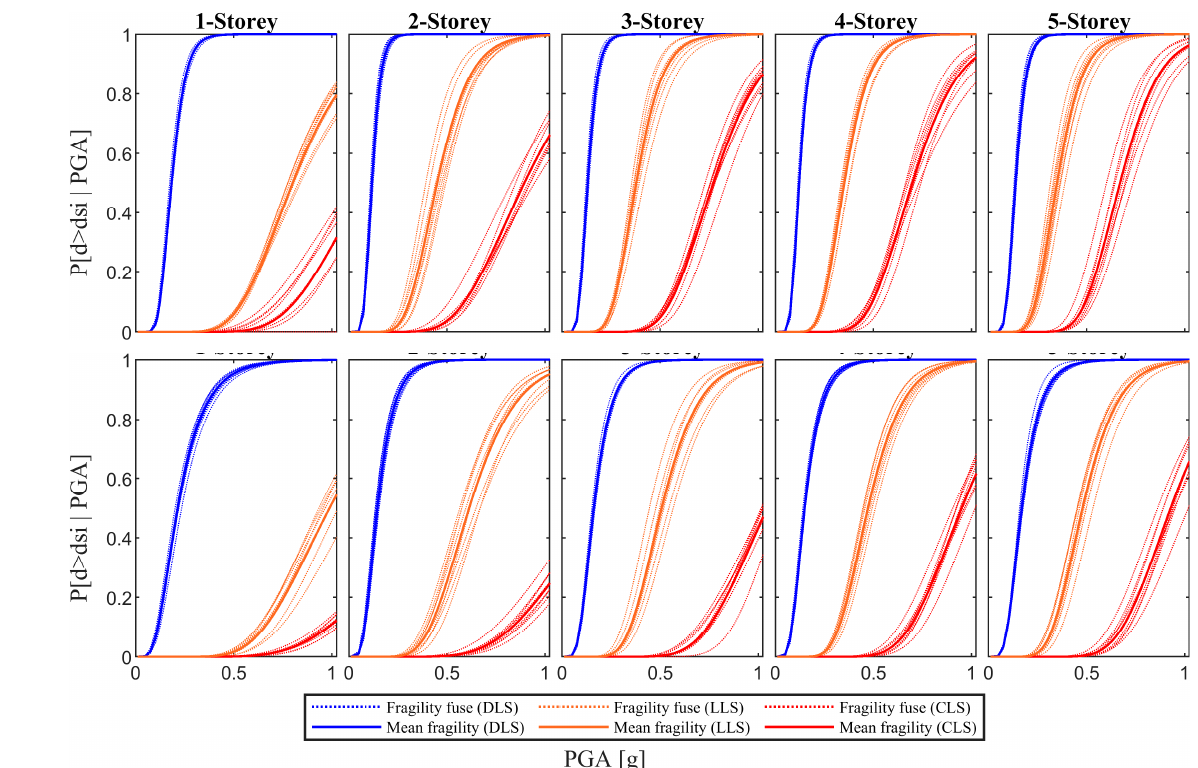
Figure 7. Resulting fragility curves for soil A; ( a ) Old; and ( b ) New. Figure 6. Resulting fragility curves for soil A; ( a ) Old; and ( b ) New.